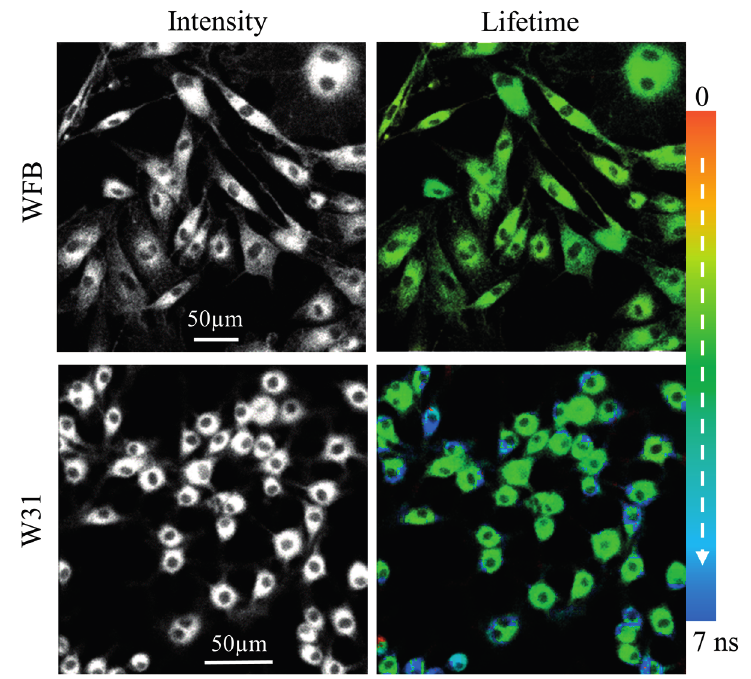
Figure 10. Fluorescence intensity images ( left ) and corresponding fluorescence lifetime images ( right ) of Na-Ph-a in WFB cells ( upper ) and in W31 cells ( lower ). Pseudocolor is used for the lifetime images to show the value of the fluorescence